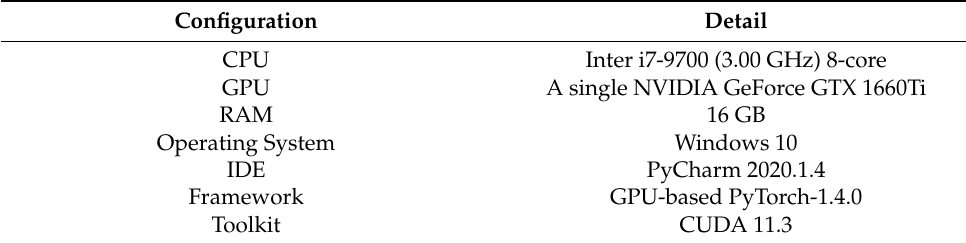
Table 1. The implementation of our